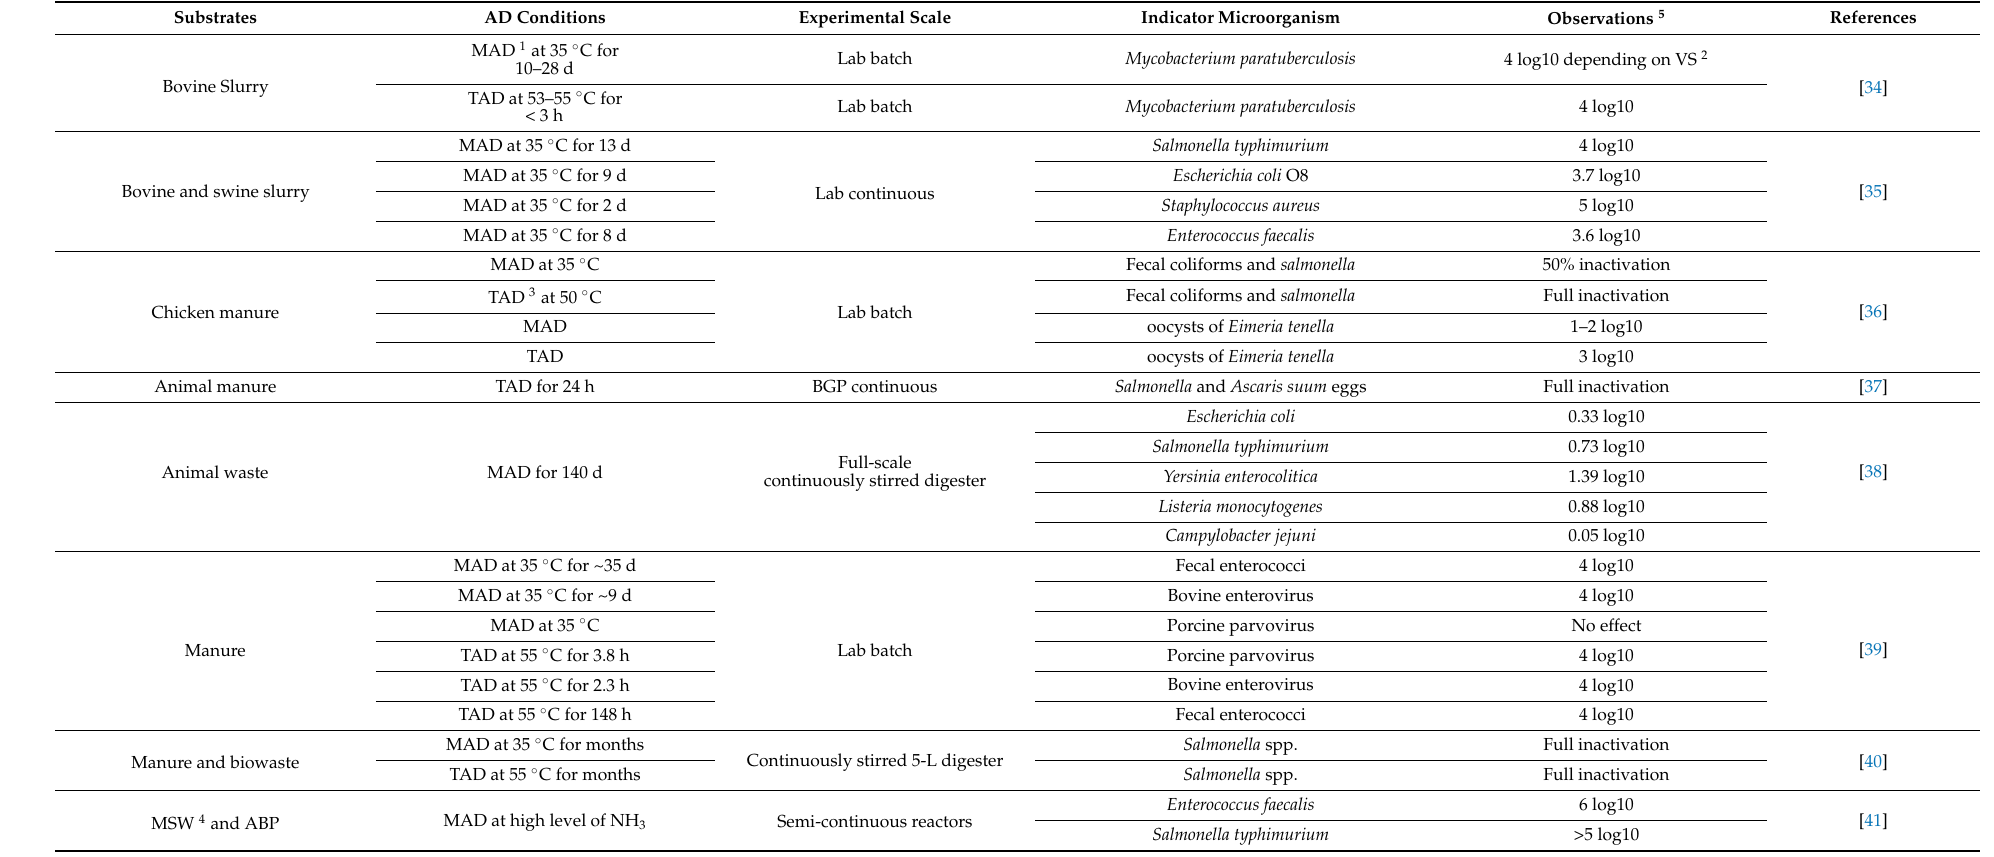
Table 3. Literature data about the efficiency of anaerobic digestion (AD) process on pathogens inactivation in animal